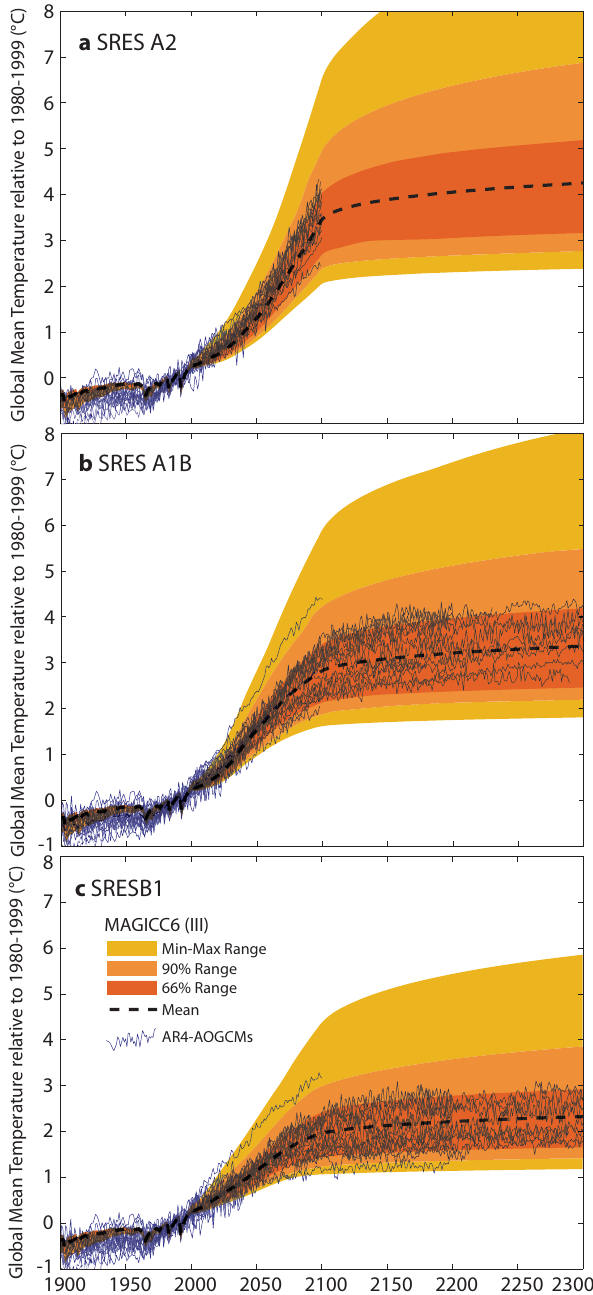
Fig. 2. Global-mean surface temperatures relative to 1980–1999 for the original AOGCMs (thin lines) and for the emulations using 10 C 4 MIP carbon cycle emulations and 19 CMIP3 AOGCM emula- tions for the three SRES scenario B1, A1B and A2 using complete, unified forcings (calibration III, as described in MRW). The shaded areas denote the ranges of the 190 cross-combinations of emula- tions, specifically the ranges in which the middle 66% (dark), 90% (medium) and all (bright patches) of the 190 emulations are